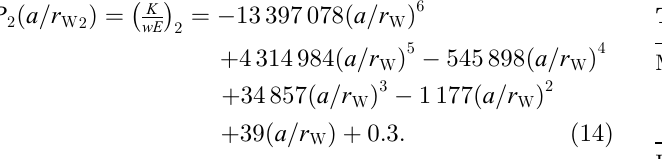
Figure 10. Example of the 1D polynomial characterization procedure for r A = r W1 ¼ 0 : 30 and r A = r W2 ¼ 0 : 897. Plotted on a logarithmic y -scale (base